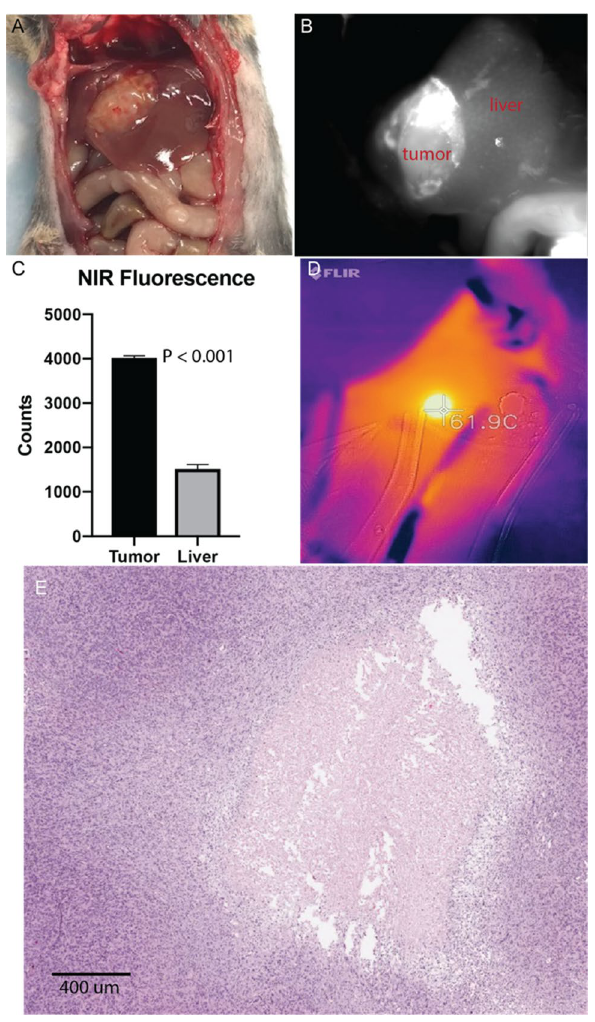
Figure 3. Molecularly targeted photothermal ablation (MTPA) of orthotopic HCC tumors. Mice with orthotopic tumors ( A ) were administered 0.5 mg/kg ICG via tail vein. MTPA was performed 6 h